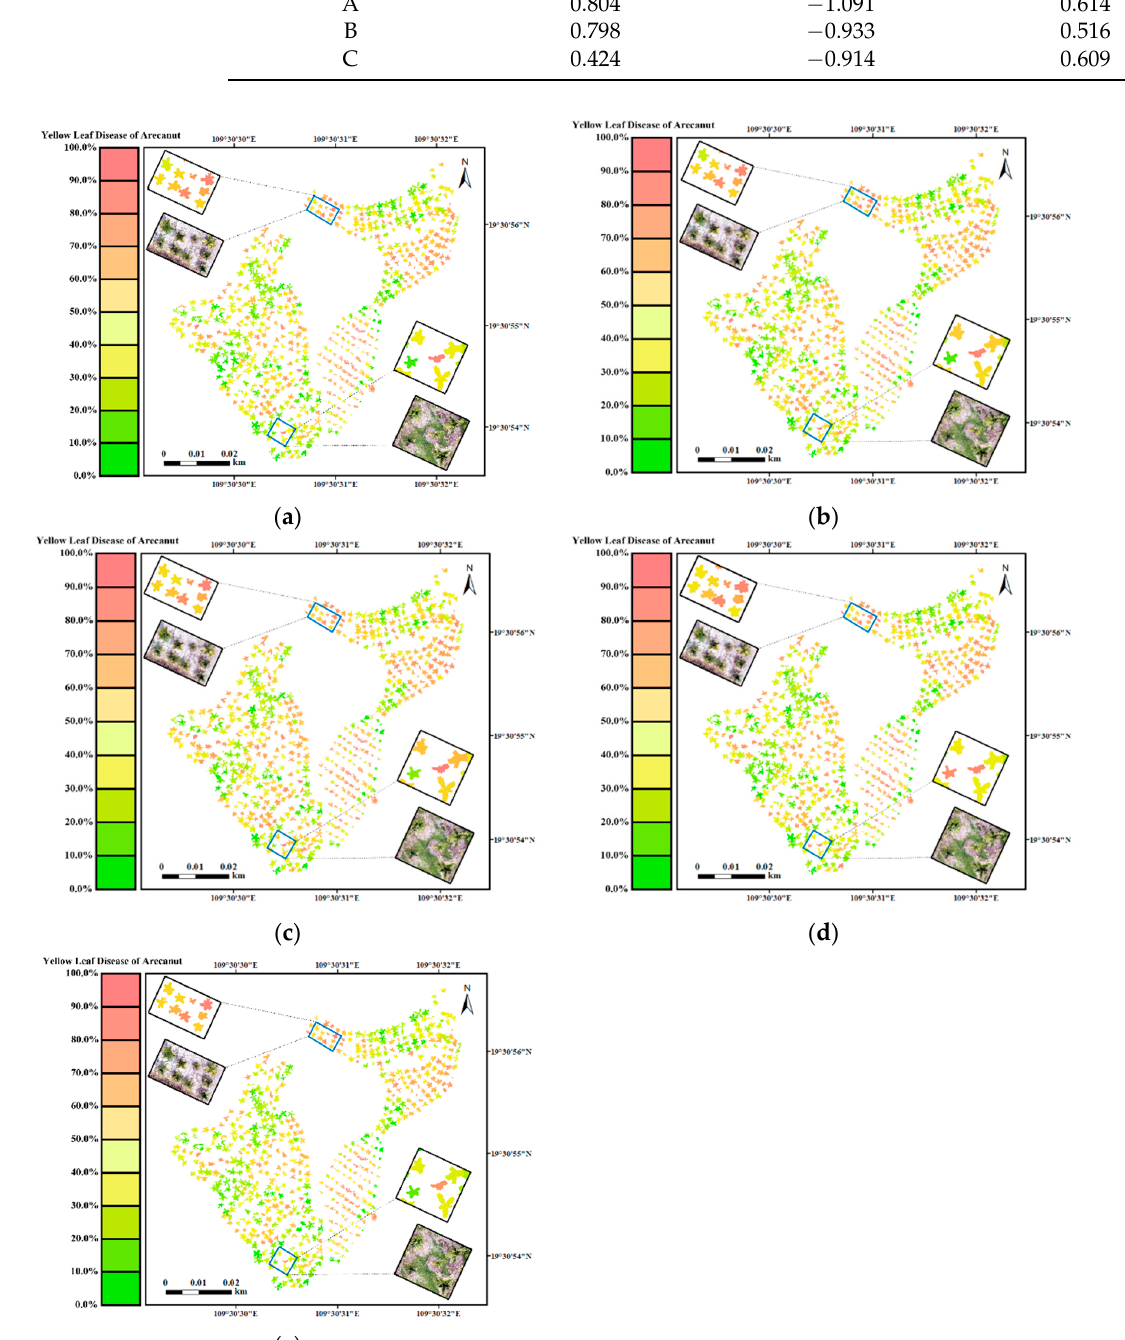
Figure 10. Prediction of the severity of the yellow leaf disease of arecanut based on five machine learning algorithms: ( a ) prediction results of BPNN algorithm; ( b ) prediction results of DT algorithm; ( c ) prediction results of naïve Bayes algorithm; ( d ) prediction results of SVM algorithm; ( e ) prediction results of k-NN classification algorithm.